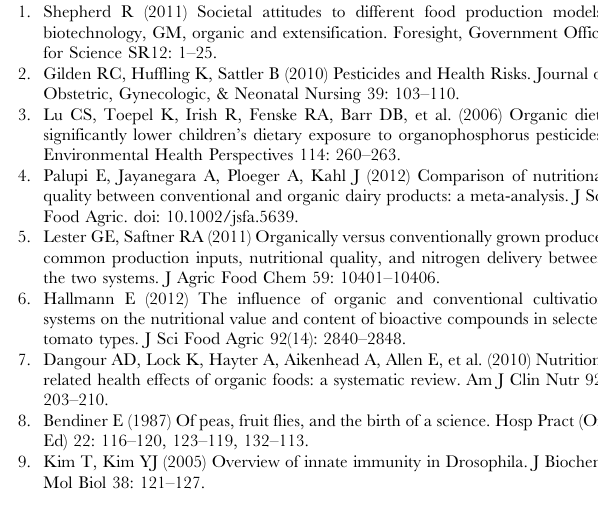
Figure S1 Spontaneous activity of fruit flies. The spontaneous activity and circadian rhythm of female fruit flies was measured after aging to 10 days on the indicated diets. No difference in circadian patterns or activity during regular resting phases was observed, but flies raised on organic raisin or banana food displayed higher activity during regular periods of activity (grey: conventional food; black: organic food). Table S1 Dietary effects on female